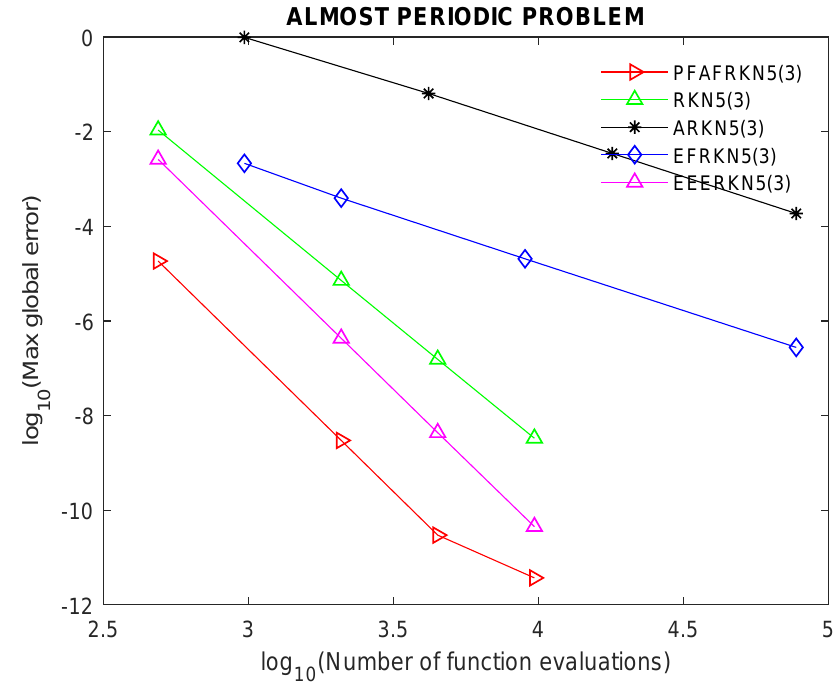
Figure 1. Efficiency curves corresponding to Problem